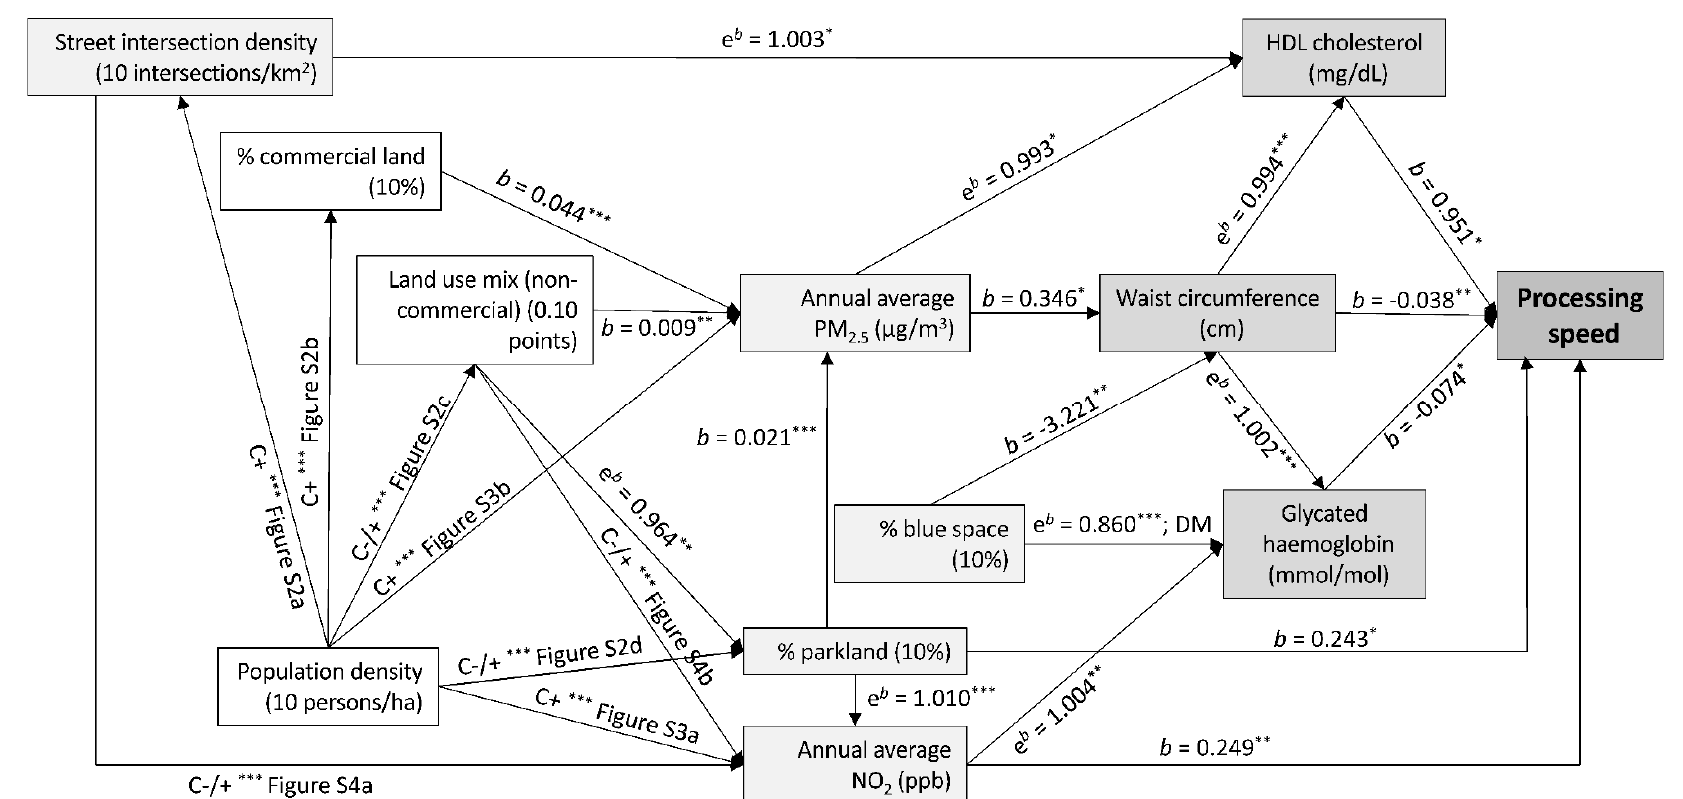
Figure 3. Effects of neighbourhood environmental characteristics on processing speed and the mediation roles of cardiovascular risk factors. Arrows linking variables indicate significant associations; b , regression coefficient; e b , exponentiated regression coefficient; ha, hectare; C+, − , +/ − = curvilinear positive, negative, non-monotonic association; Figure Sx; supplementary figure of a curvilinear association. * p < 0.05; ** p < 0.01; *** p < 0.001. Cardiometabolic risk factors are represented by darker grey rectangles; environmental characteristics directly associated with memory or cardiometabolic risk factors are represented by light grey rectangles; environmental attributes indirectly associated with cardiometabolic risk factors through other environmental characteristics are represented by white rectangles. All significant and non-significant associations (regression coefficients and 95% CIs) are presented in the Supplementary Materials (Tables S2–S4). Table S2 also provides the F-ratio of the smooth terms for significant curvilinear associations.